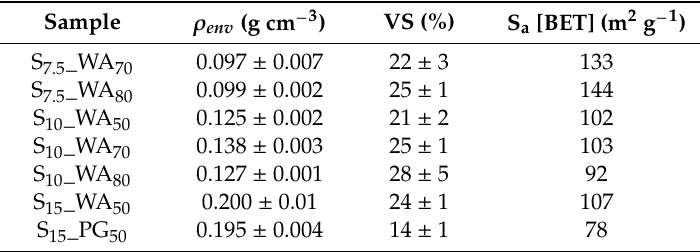
Table 3. Textural properties of aerogels samples prepared with water and propylene glycol as